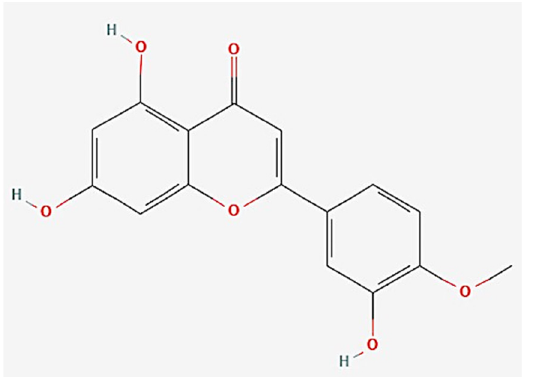
Figure 2. Chemical structure of diosmetin. https://pubchem.ncbi.nlm.nih.gov/compound/ Diosmetin#section=Structures (accessed on 28 January